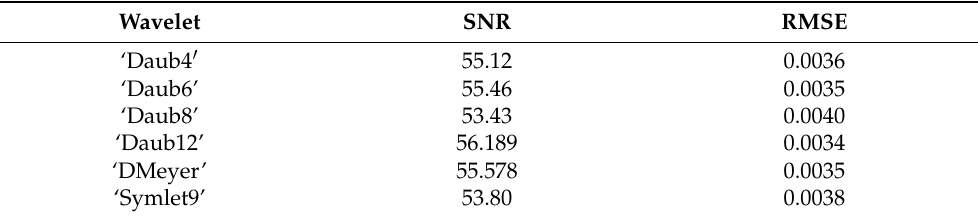
Table 1. Performance comparison of different wavelet families, applied to EEG channels, in terms of signal-to-noise ratio (SNR), and root mean square error (RMSE).